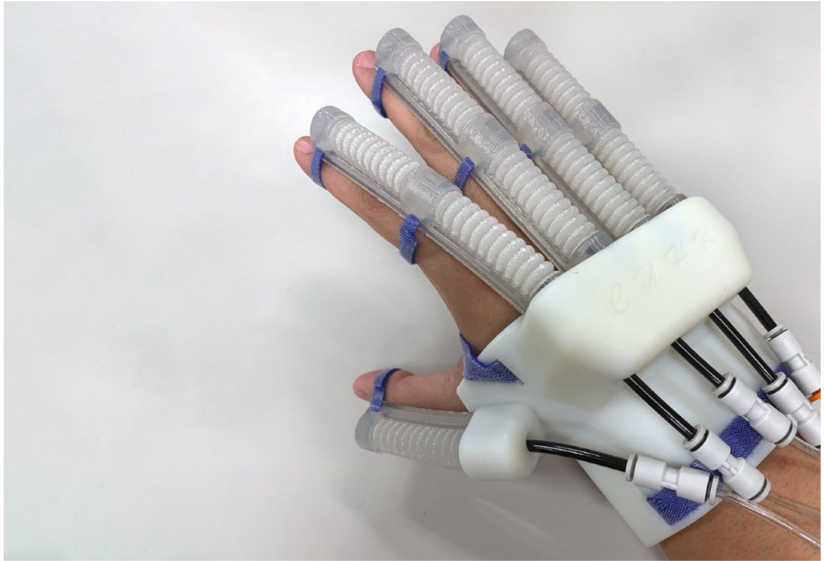
Figure 8. Soft Robotic Glove for